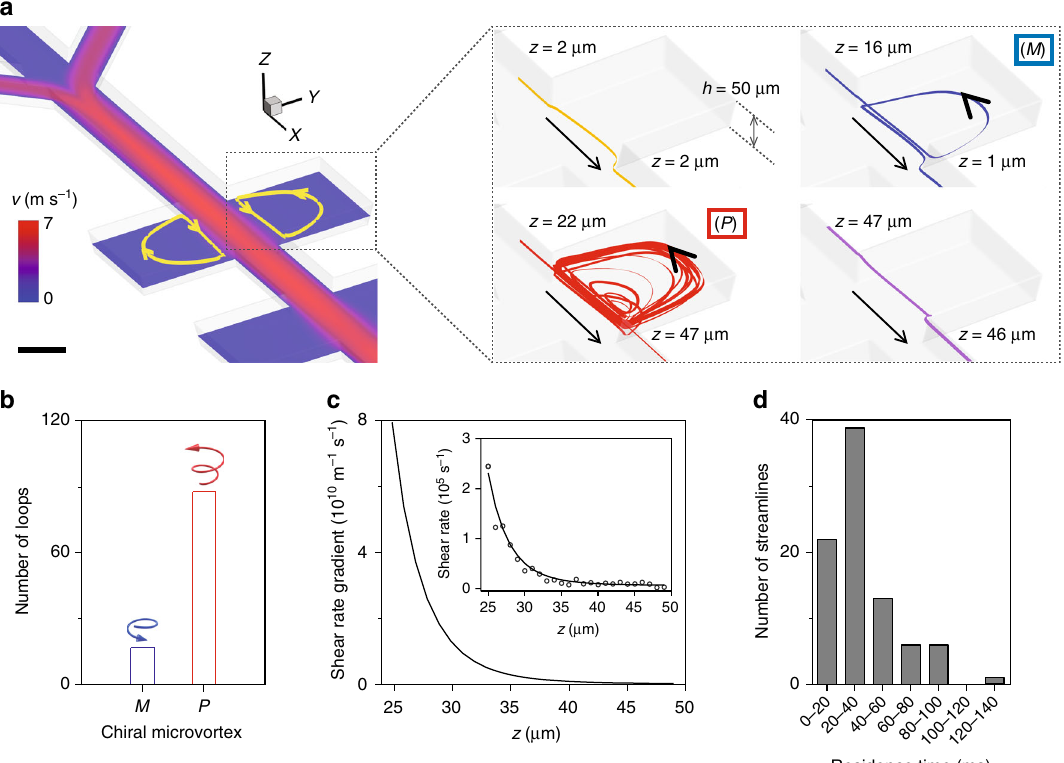
Fig. 4 Analysis of laminar chiral microvortices. a CFD simulation shows that fl uid can rotate upward (red curves) or downward (blue curves) to generate laminar P - or M- chiral microvortices in the left microchamber. The color bar indicates the magnitude of fl ow velocity. The channel height is 50 μ m. Scale bar, 100 μ m. b A majority (~84%) of microvortices rotate upward, suggesting a predominantly P chirality (red bar) in the left microchamber. c Shear rate gradient from P -chiral microvortices in the left microchamber. Insert: shear rate (black line) obtained from simulation results (void black circles). d Residence time (gray bars) of nuclei within the left microchamber from simulation